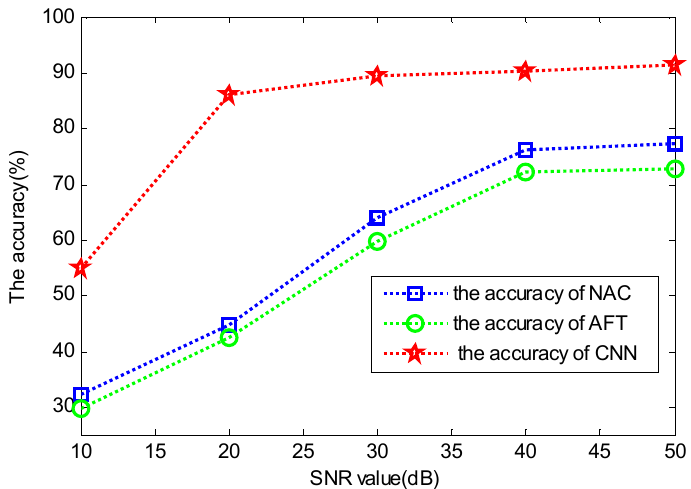
Figure 12. The ASP measurement performance comparison of the three methods.